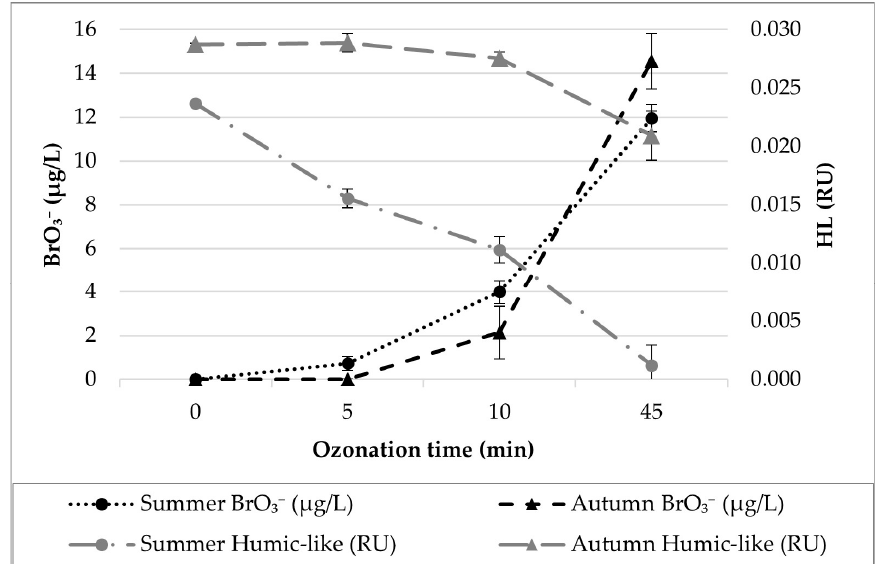
Figure 2. Formation of bromate and decomposition of HL fluorescence at the ozone dose of 0.3 mg/L without NH 4+ addition.